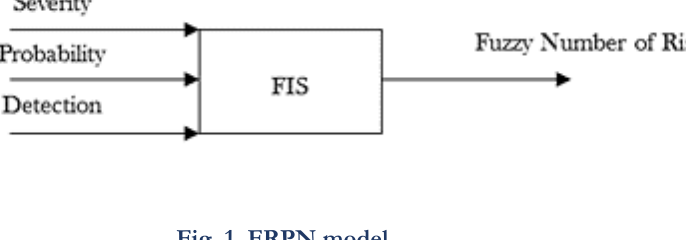
Fig. 1. FRPN model.